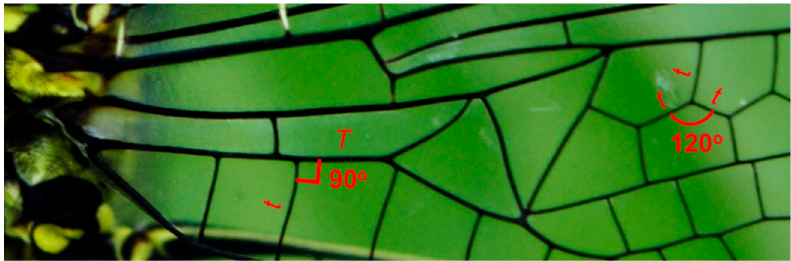
Figure 17. Thompson [75] postulated that when the “tensions” in veins had large differences (T > t), the veins would meet at right angles, approaching 120° as the tensions in coincident veins equaled each other.